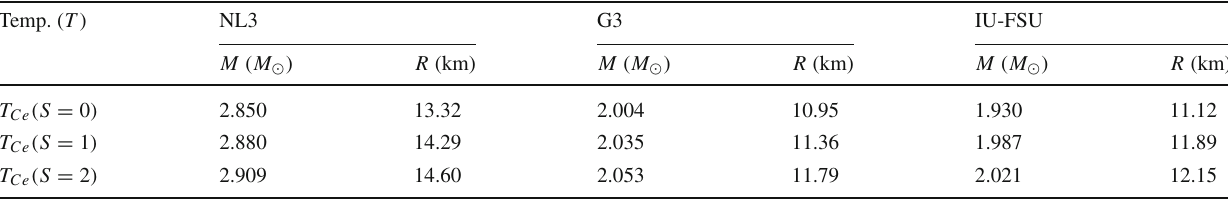
Table 3 Maximum mass and radius of the PNS for NL3, G3 and IU-FSU parameter sets calculated using constant temperature EoS. The central temperature at S = 0, 1 and 2 for the corresponding parameter set have been used as the constant temperature Temp. ( T ) NL3 G3